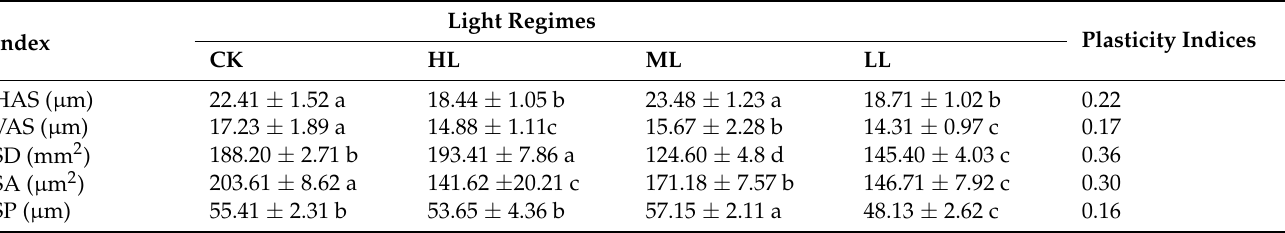
Table 3. Stomatal structure characteristic parameters of C. oleifera leaves under different light re- gimes.